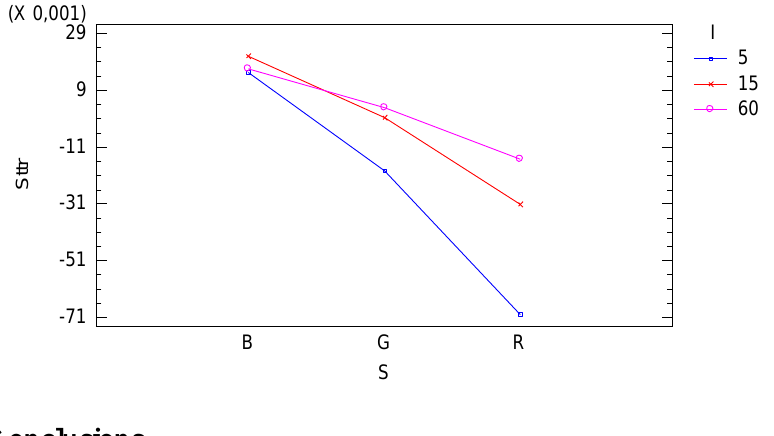
Figure 13. Sttr vs. spectral response factor S ( λ ), according to the 3 levels (5, 15, 60 s) of the time interval factor I